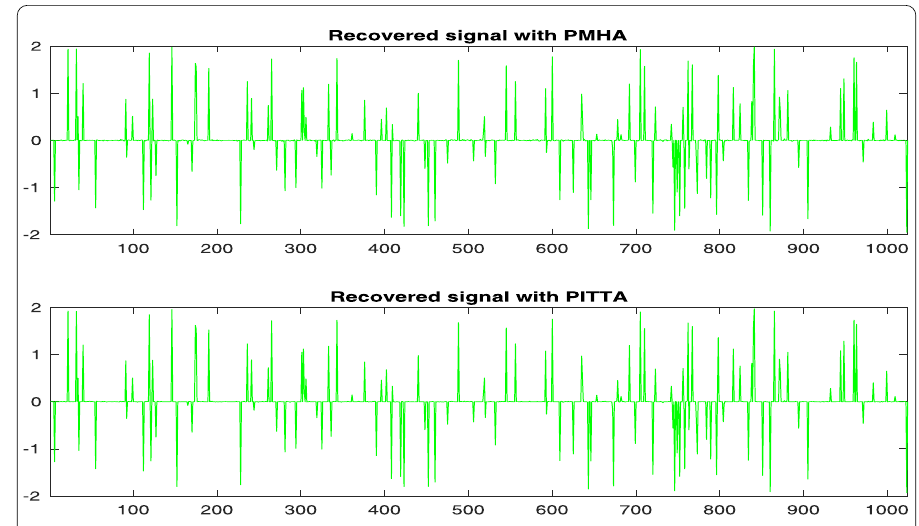
Figure 7 From top to bottom: the reconstructed signals by the two algorithms in Table 9 for m = 128